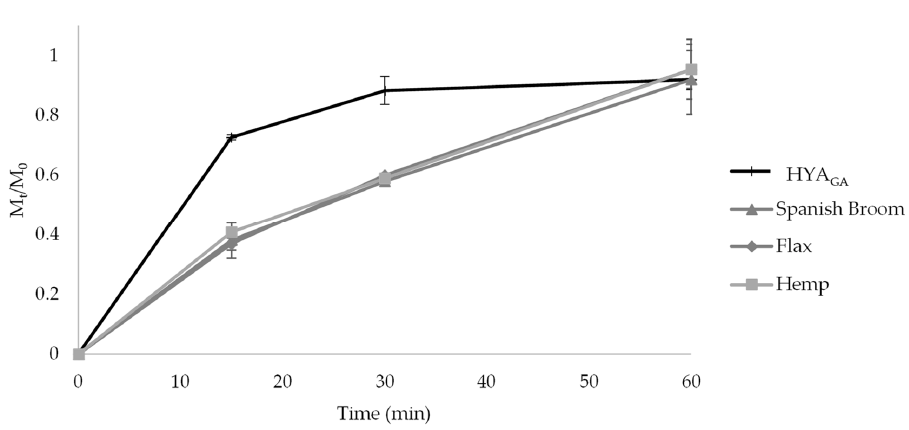
Figure 5. In vitro GA release in PBS:EtOH (7:3 v / v ) from HYA GA and from Spanish Broom, flax and hemp wound dressings loaded with HYA GA (mean ± SD, n = 3).